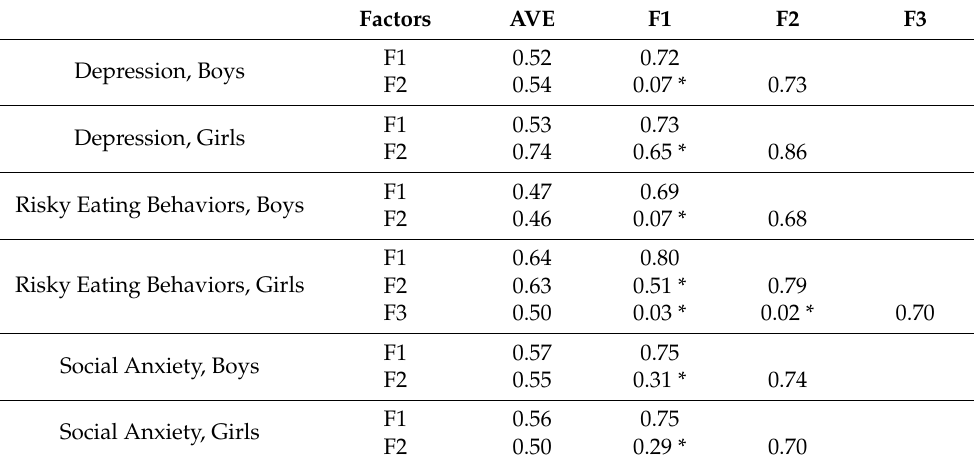
Table 4. Correlation between variables and average